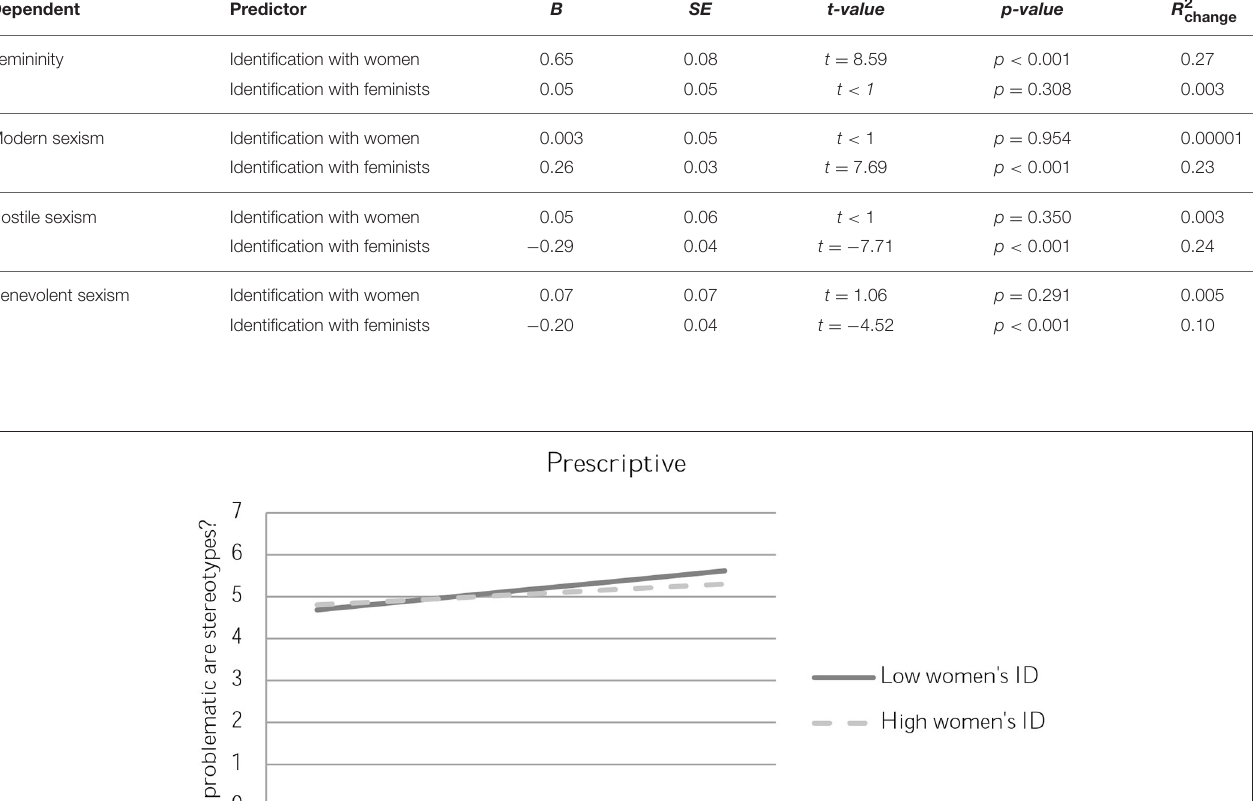
TABLE 7 | Attitudes predicted by identification with women, and identification with feminists in Study 4. Dependent